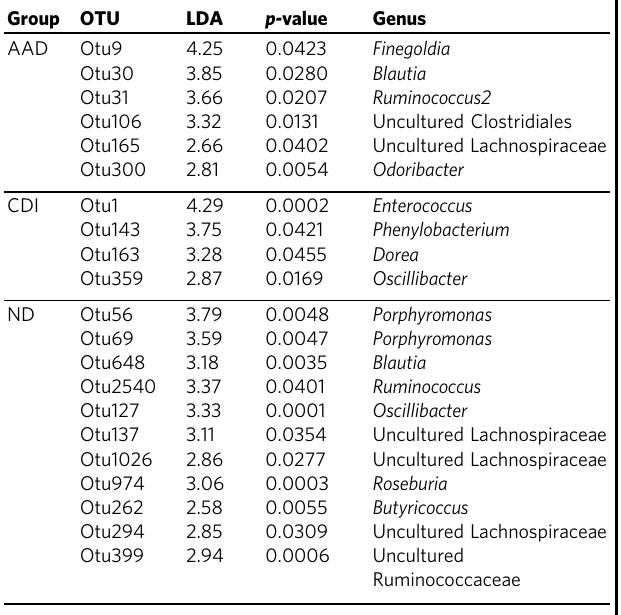
Table 2 Identi fi cation of microbiota-based markers at D1. Group OTU